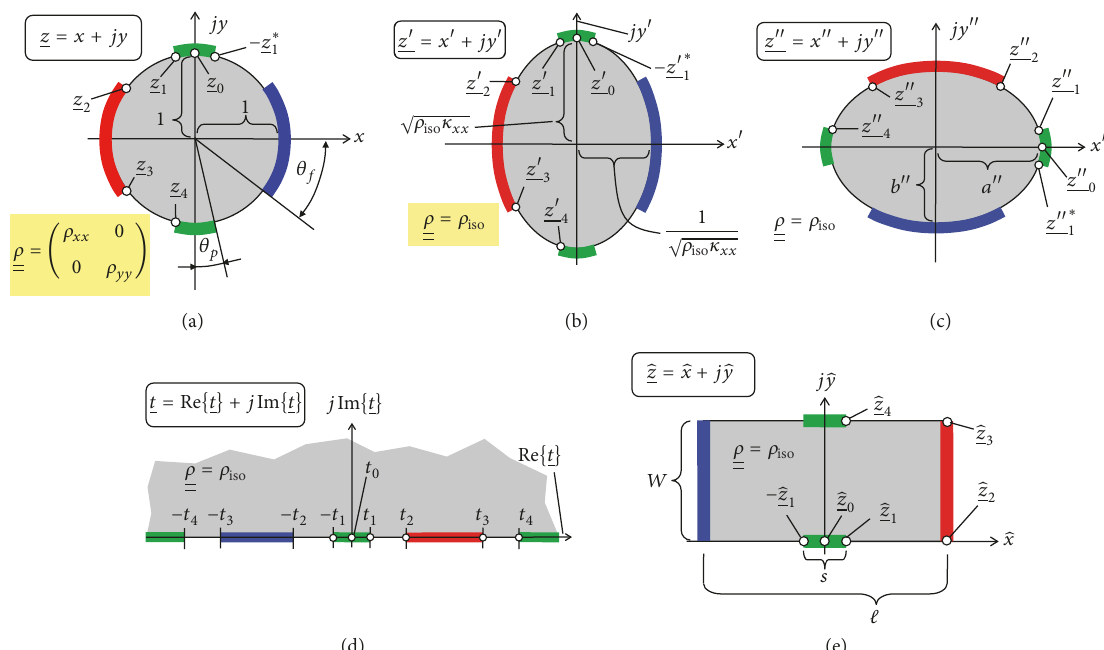
Figure 10: (a–d) Mapping a circular device with anisotropic conductivity by one affine and three conformal transformations onto an equivalent rectangular device with isotropic conductivity. (a) shows a circular disk shaped device with two pairs of contacts and two perpendicular mirror-symmetry axes 𝑥 and 𝑦 . Its resistivity is anisotropic with the principal axes x and y . This describes the action of biaxial load along 𝑥 - and 𝑦 -axes on chips in (100)-silicon aligned like in Figure 1. The elliptical device in (b) with isotropic resistivity is equivalent to the device in (a). The shape in (b) is obtained by the affine transformation 𝑧 → 𝑧 󸀠 (12a). The conformal transformation 𝑧 󸀠 → 𝑧 󸀠󸀠 rotates the device clockwise by 90 ∘ and scales it isotropically: 𝑎 󸀠󸀠 = 𝜌 iso 𝜅 𝑥𝑥 /√(𝜌 iso 𝜅 𝑥𝑥 ) 2 − 1 and 𝑏 󸀠󸀠 = 1/√(𝜌 iso 𝜅 𝑥𝑥 ) 2 − 1 with 𝑎 󸀠󸀠2 − 𝑏 󸀠󸀠2 = 1 . A second-conformal transformation 𝑧 󸀠󸀠 → 𝑡 (26a) and (26b) maps the interior of the ellipse in (c) onto the upper half of the t -plane in (d). A third-conformal transformation 𝑡 → ̂𝑧 maps the upper half of the t -plane into the interior of the rectangle in (e). The contacts along the perimeter of the shapes relate to the contacts on the real t -axis. Corresponding points have equal indices. The sequence of points with indices 0, 1, 2, 3, and 4 is always counterclockwise while the conductive region is at the left hand side of this path. The asterisk means the conjugate